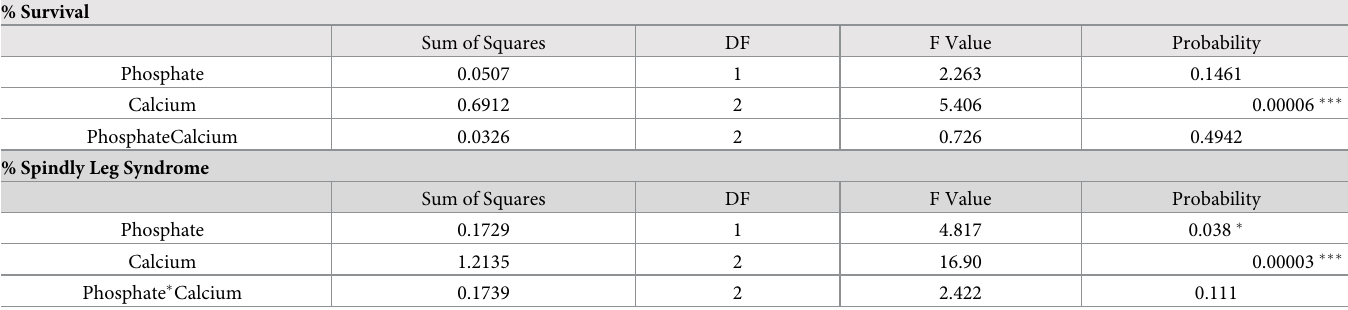
Table 2. 2-way ANOVA testing for the experimental effects of added calcium and phosphate on Atelopus varius tadpole survival, and prevalence of spindly leg syn- drome in A . varius metamorphs.